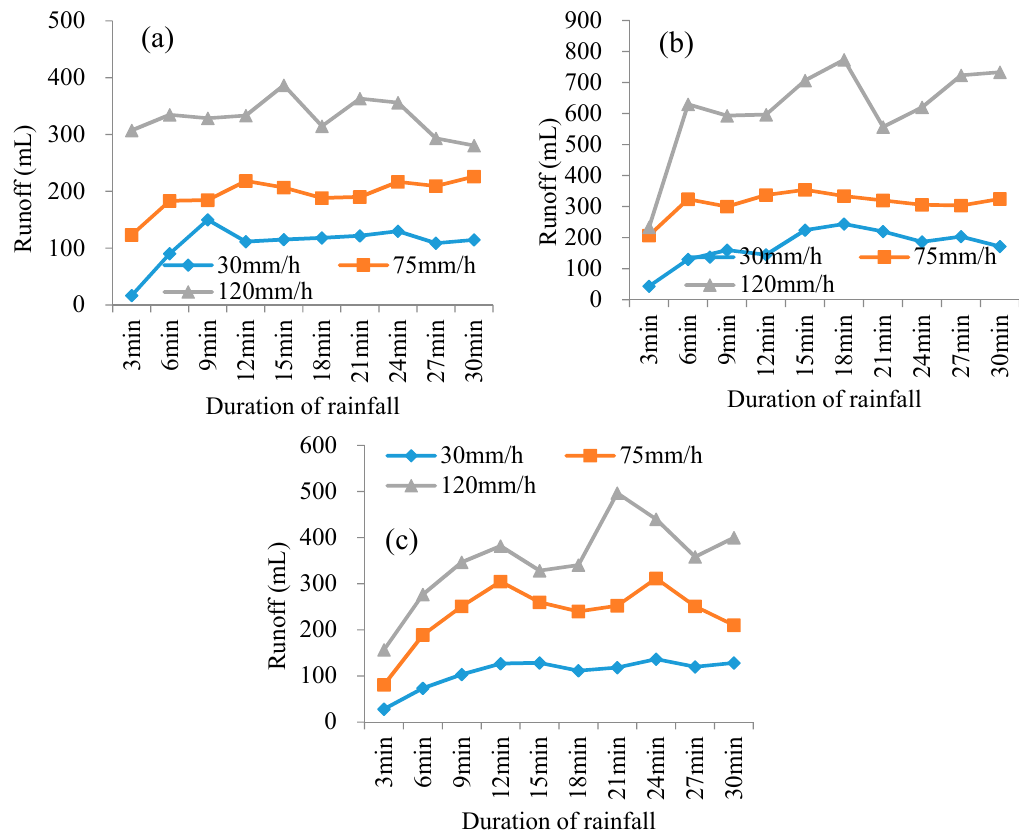
Figure 4. Runoff variations under different rainfall intensities. ( a ) T-L type; ( b ) T-H type; and ( c ) M type.